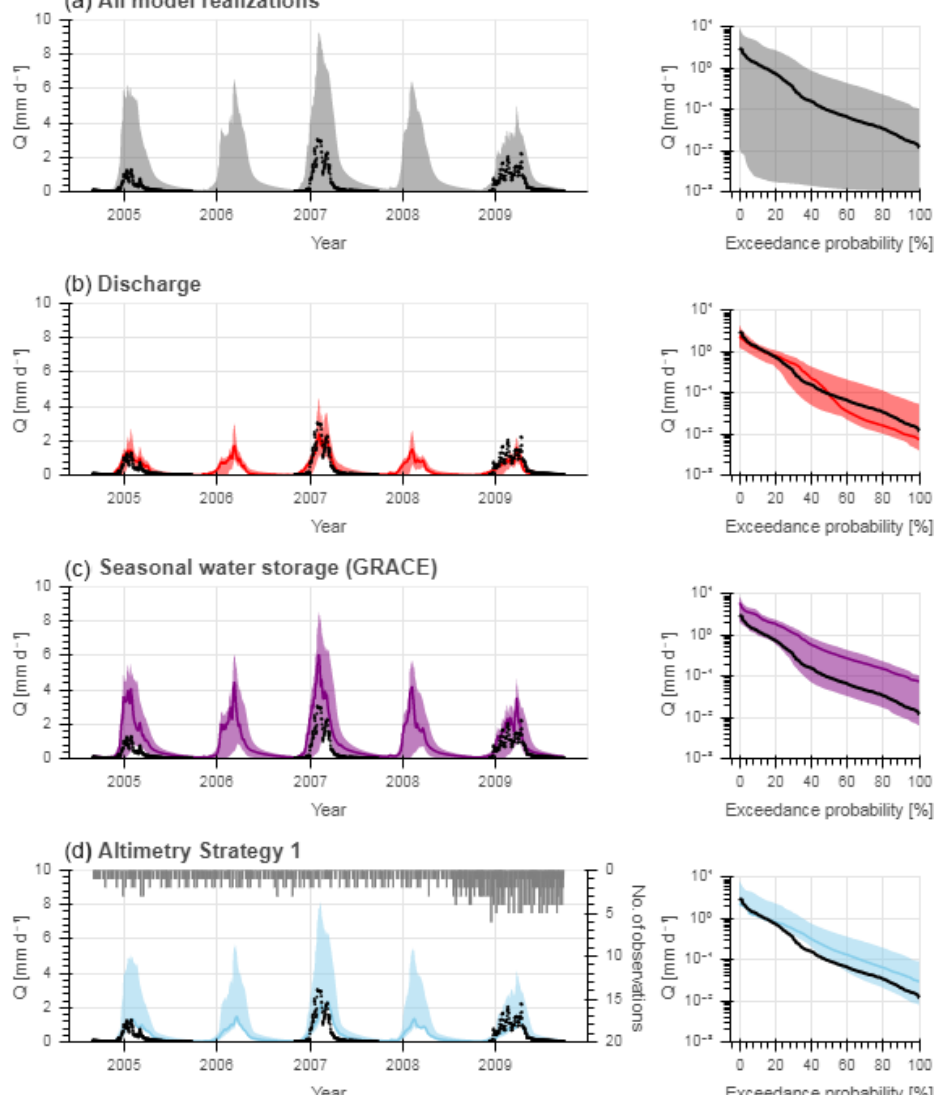
Figure 6. Range of model solutions. The left subplots show the hydrograph and the right subplots the flow duration curve of the recorded (black) and modelled discharge: the line indicates the solution with the highest calibration objective function ( E NS or D E ) and the shaded area the envelope of the solutions retained as feasible. (a) All model solutions included solutions retained as feasible based on (b) discharge (i.e. “traditional calibration”; E NS ,Q ), (c) GRACE ( E NS ,S ), and (d) Altimetry Strategy 1 only ( D E,R,WL ). The grey bars in the left subplot (d) tot indicate the number of altimetry observations available for each